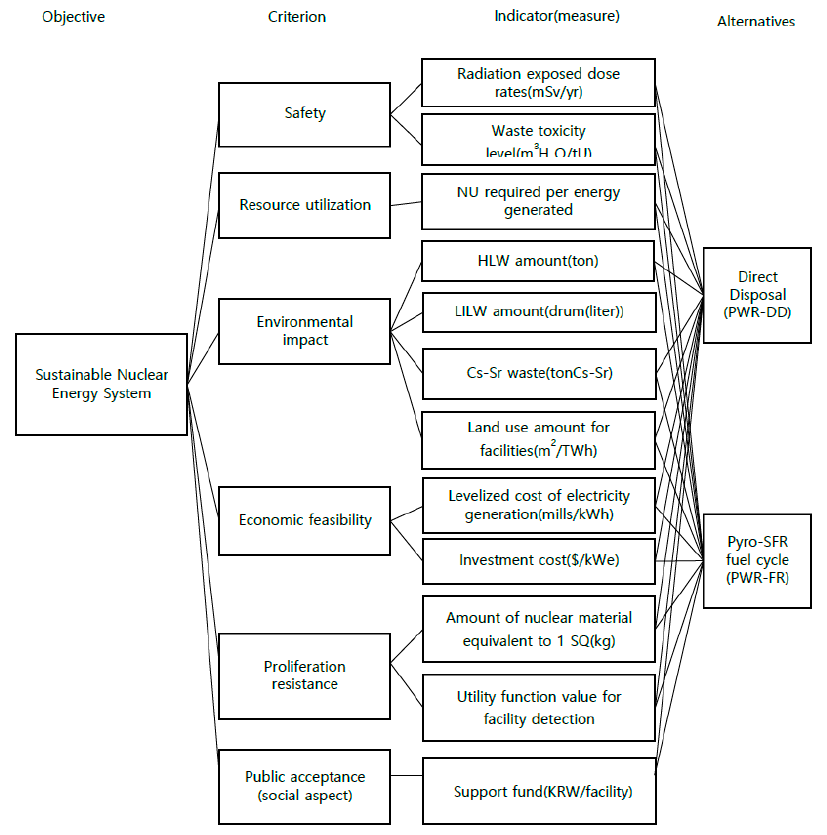
Figure 1. Evaluation criteria and evaluation index for two alternatives. Table 2. Evaluation criteria and evaluation index.